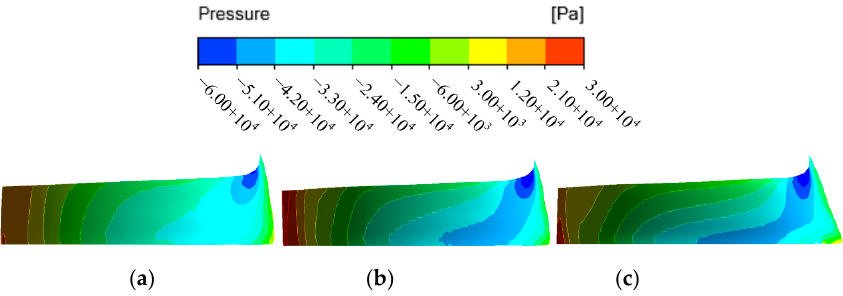
Figure 6. Static pressure at the suction surface for different ND B (the second interaction point between the straight line and the parabolic line at the band): ( a ) ND B = 0.55; ( b ) ND B = 0.75; ( c ) ND B = 0.95.